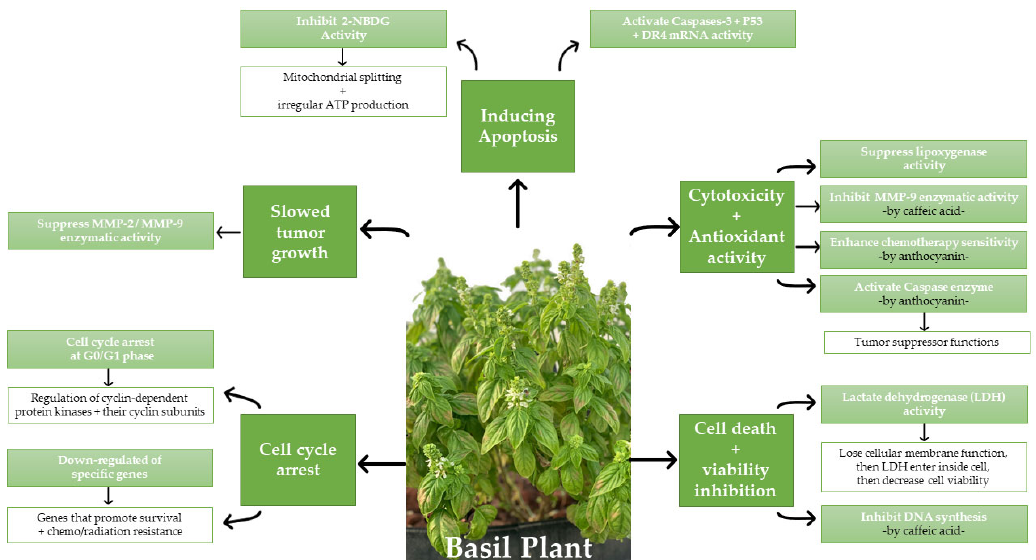
Figure 1. Main mechanisms and effects of Ocimum (basil) in immunomodulation and inflammation response.